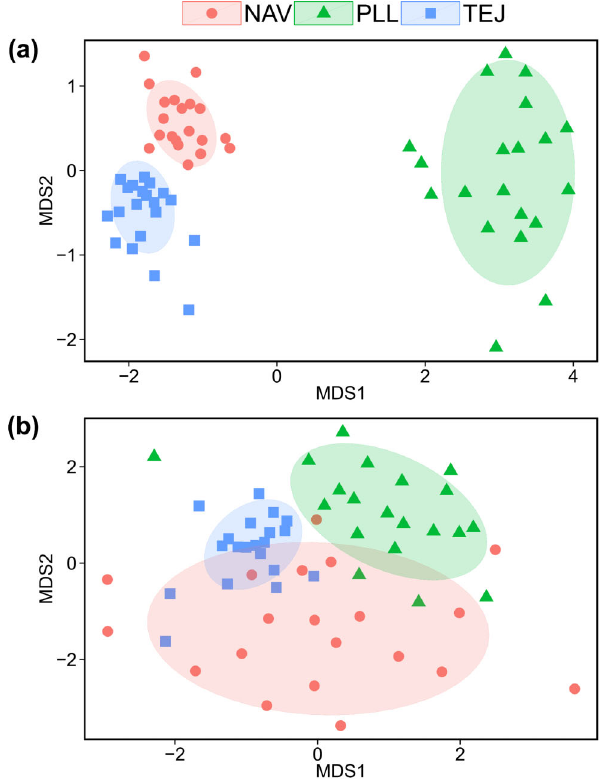
Figure 1. Epigenetic structure of sporophyte and descendant gametophyte populations. Scatterplot of Helleborus foetidus sporo- phyte ( a ) and descendant male gametophyte ( b ) populations on the plane defined by nonmetric multidimensional scaling axes (MDS1 and MDS2) from the respective pairwise matrices of epigenetic distance. Each symbol represents a sample, coded according to sampling site (NAV, TEJ and PLL), and ellipses denote the 95% bivariate confidence intervals around site